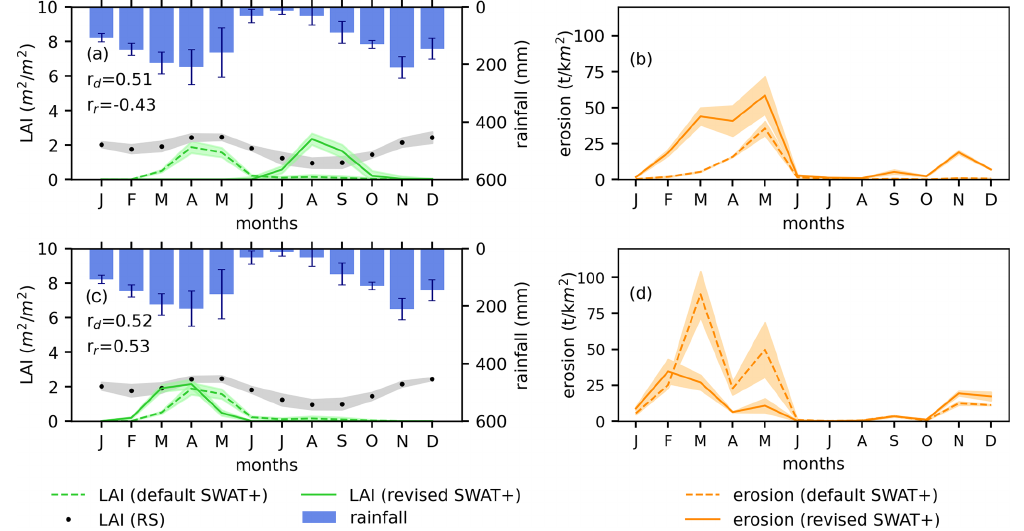
Figure A3. Monthly mean and standard deviation (bands) of (a, c) LAI and (b, d) erosion comparison for irrigated soybean case 1 (irrigation during the dry growing season) and for irrigated soybean case 2 (irrigation during the main wet growing season), respectively, in the Victoria Basin. The LAI correlation coefficients ( r d for the default SWAT + model and r r for the revised SWAT + model) are shown.